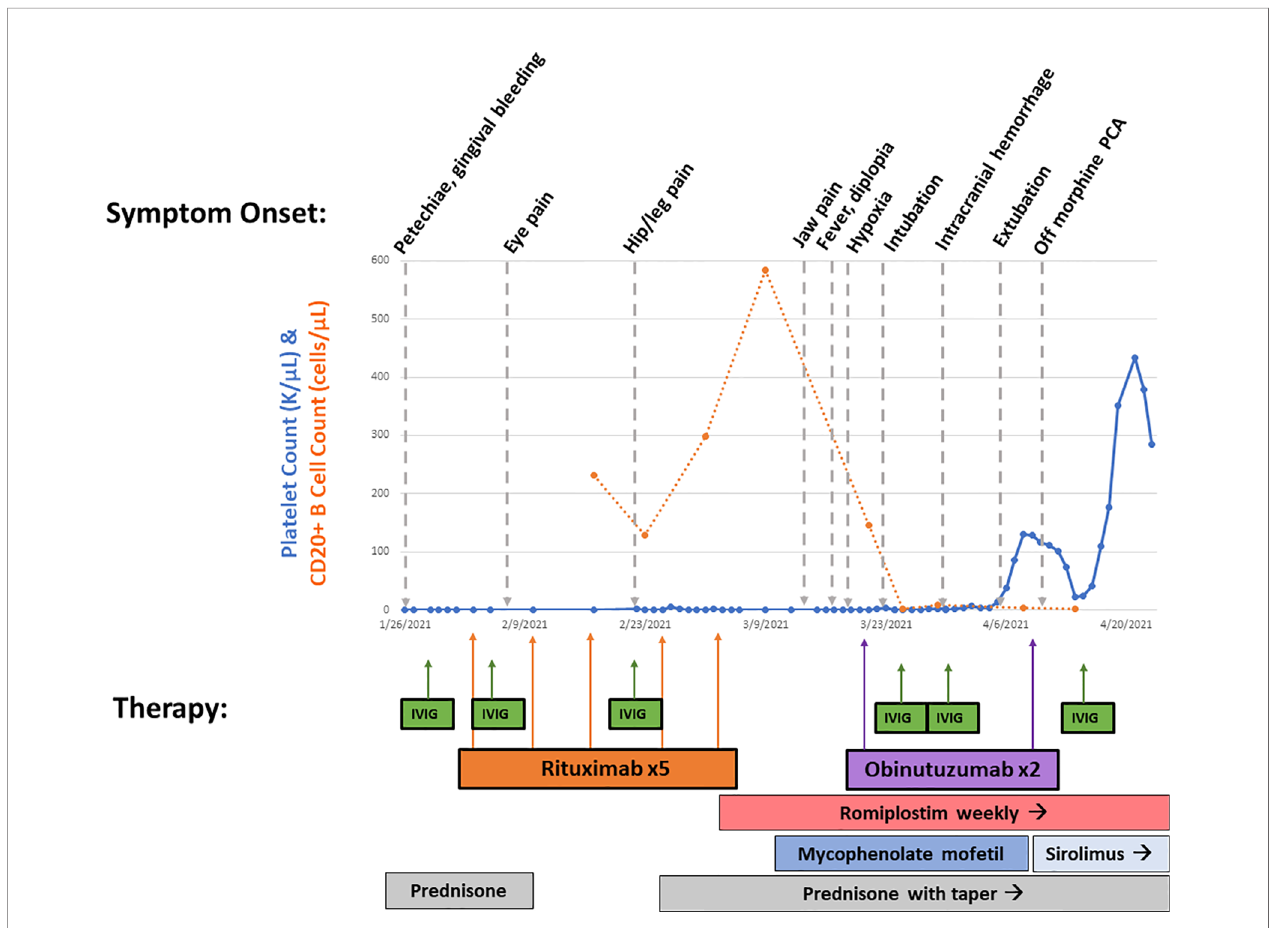
FIGURE 2 | Overview of treatment course. Platelet count (in K/µl, solid line) and CD20+ B-cell count (in cells/µl, dotted line) from beginning of presentation until hospital discharge is shown. Symptom onset is shown on top, while therapies are shown on bottom with corresponding arrows. This demonstrates rapid B-cell depletion following obinutuzumab therapy with gradual rise in platelet